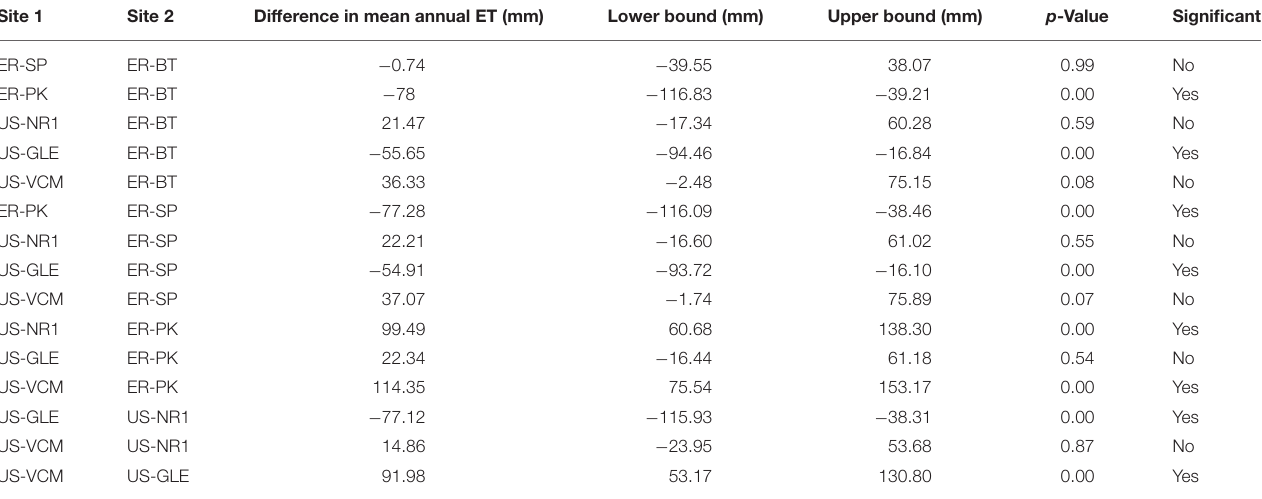
TABLE 2 | Tukey’s test result indicates differences in annual ET for certain pairs at family-wise 95% level. Site